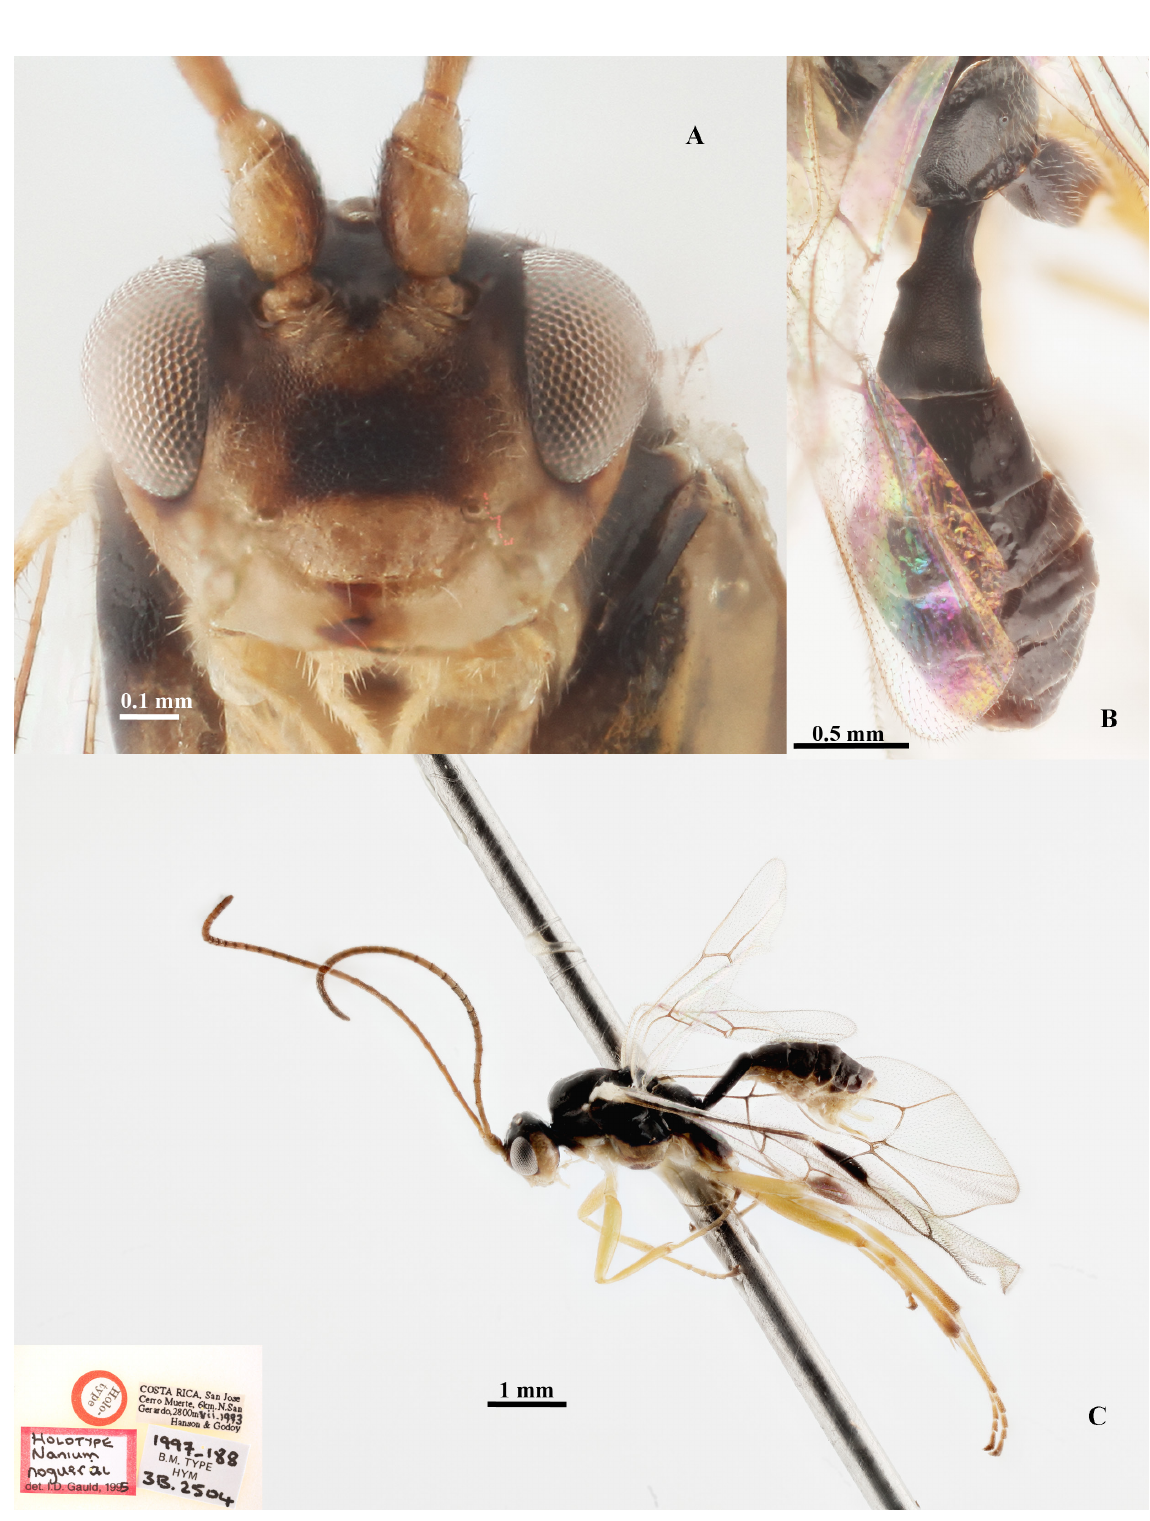
Fig. 6 . Nanium nogueri Gauld, 1997, holotype, ♀ (BMNH). A . Face. B . Metasoma (dorsal view). C .